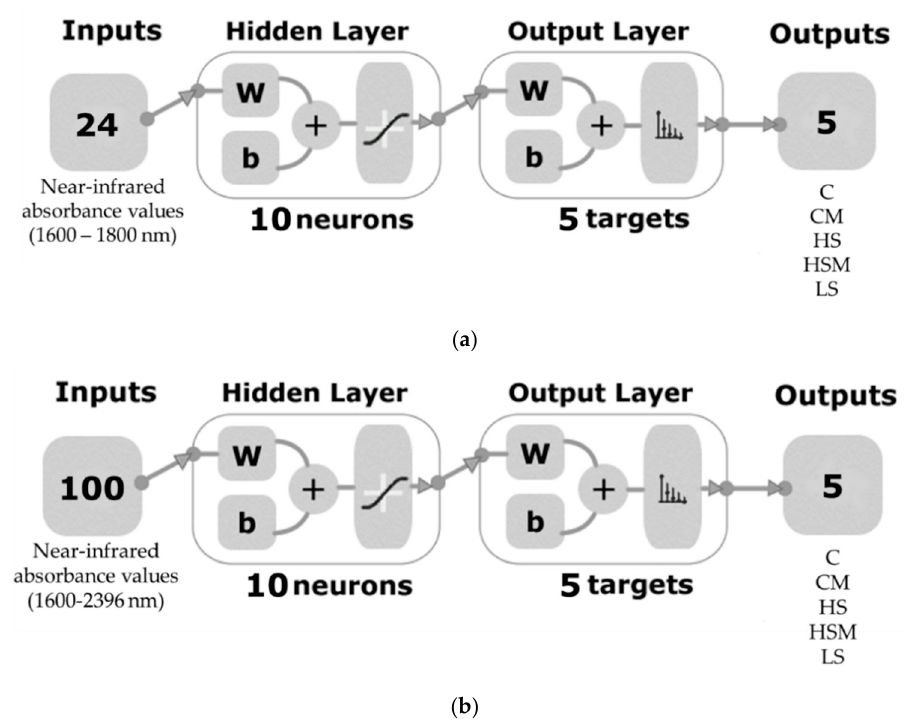
Figure 2. Two-layer feedforward network with ten hidden neurons and sigmoid function for the three classification models: ( a ). microPHAZIR TM leaf model (Model 1) and ( b ). microPHAZIR TM berry model (Model 2). Abbreviations: C = control without misting; CM = control with misting; HS =